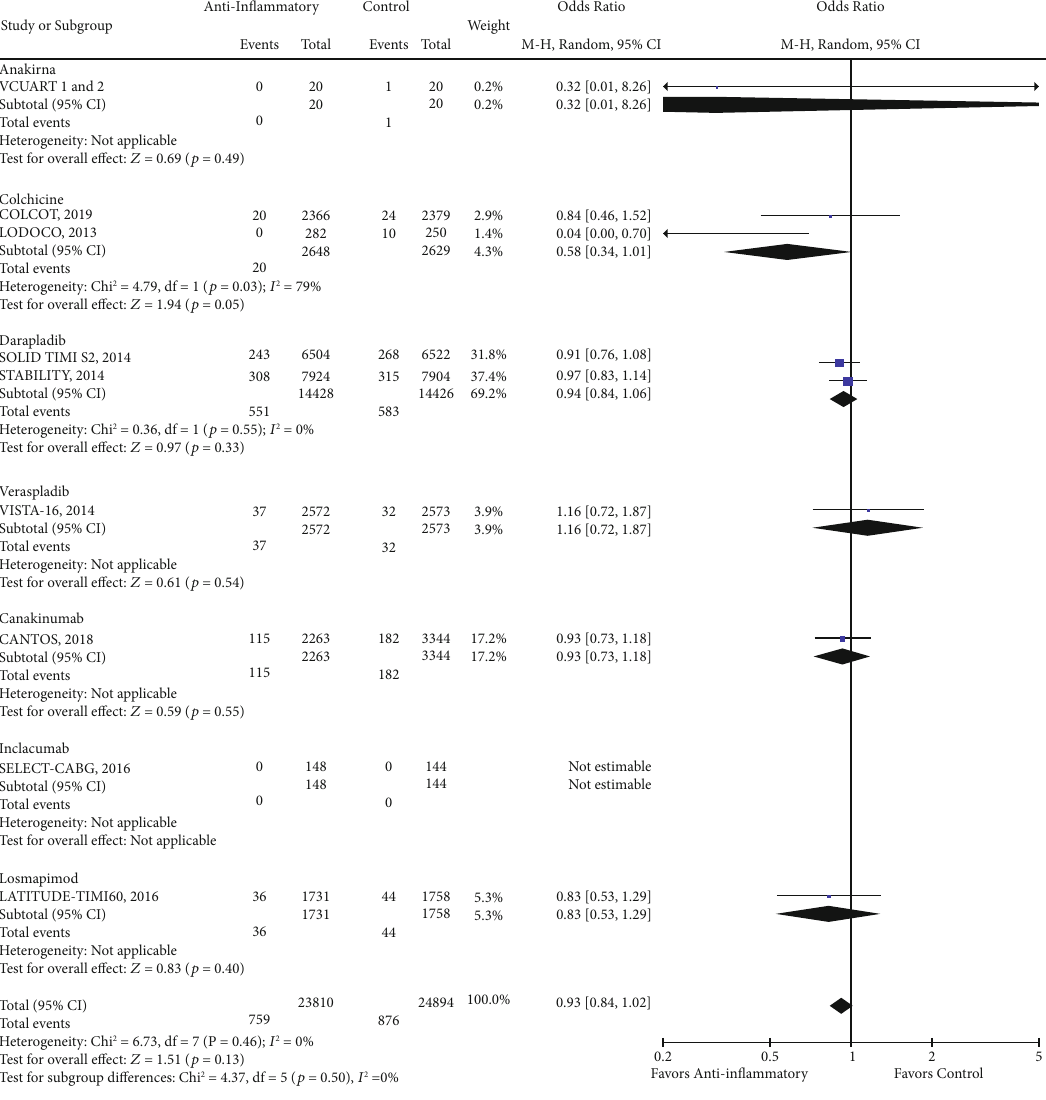
Figure 3: Forest plot of cardiac mortality. There was no signi fi cant di ff erence between anti-in fl ammatory therapy and standard therapy alone regarding cardiovascular mortality (OR 0.93, CI 0.84-1.02; P = 0 : 13